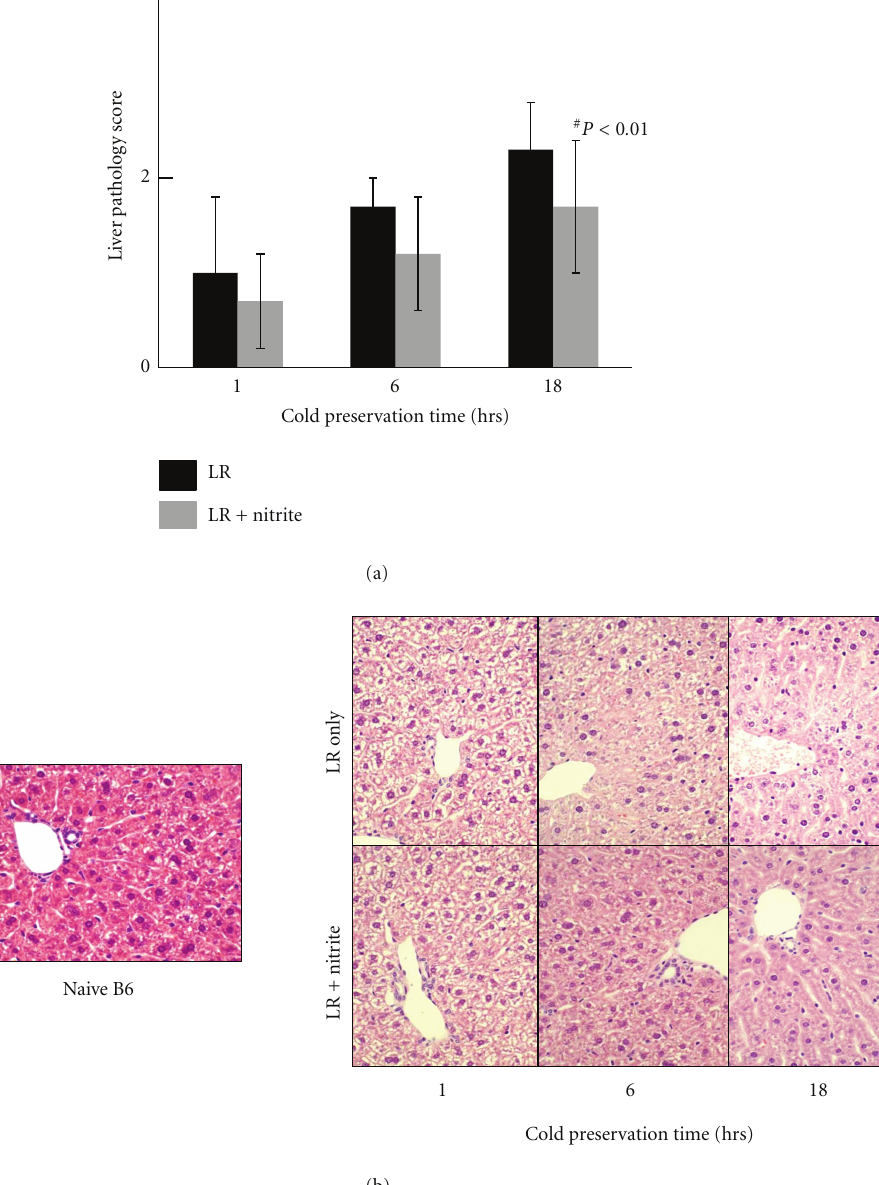
Figure 4: Liver pathology scores decreased with nitrite. Increased hepatocyte swelling, increased cytoplasmic vacuolization, nuclear pyknosis, sinusoidal dilatation, and focal necrosis in LR only group with maximal injury at 18hrs are observed. These findings were significantly reduced at 18hrs with 25 µ M of anion nitrite (2 . 4 ± 0 . 8 versus 1 . 7 ± 0 . 7). Data are expressed as mean ± SE. # P < 0 . 05 for corresponding